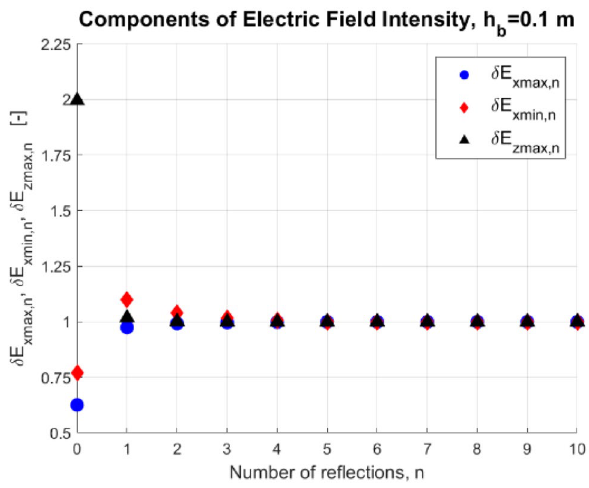
Figure 7. Dimensionless components of electric field intensity ( h w = 10 m, h b = 0.1 m, z = − 9 m, n —number of reflections).